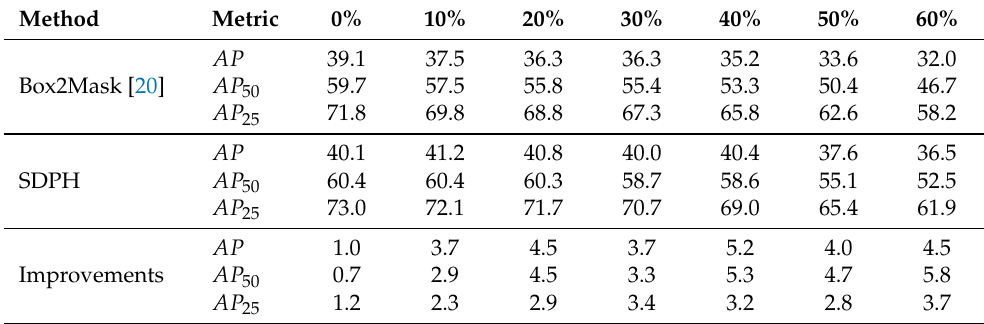
Table 1. Quantitative comparison of different noise rates on ScanNet-v2.